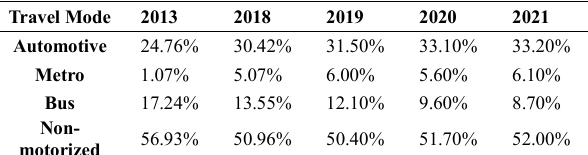
Table 2. Changes in travel mode shares from 2013 to 2021